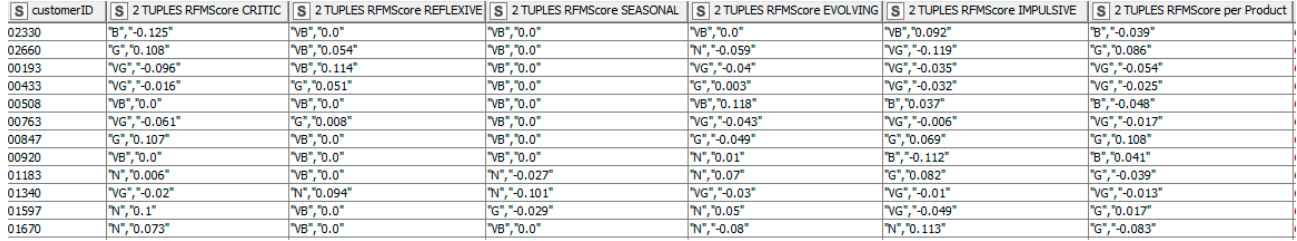
Figure 11. Output table from Knime. Sample of customers with their fuzzy linguistic 2-tuple RFMScore per product hierarchy ( VU e ) and the global RFMScore ( A e ).